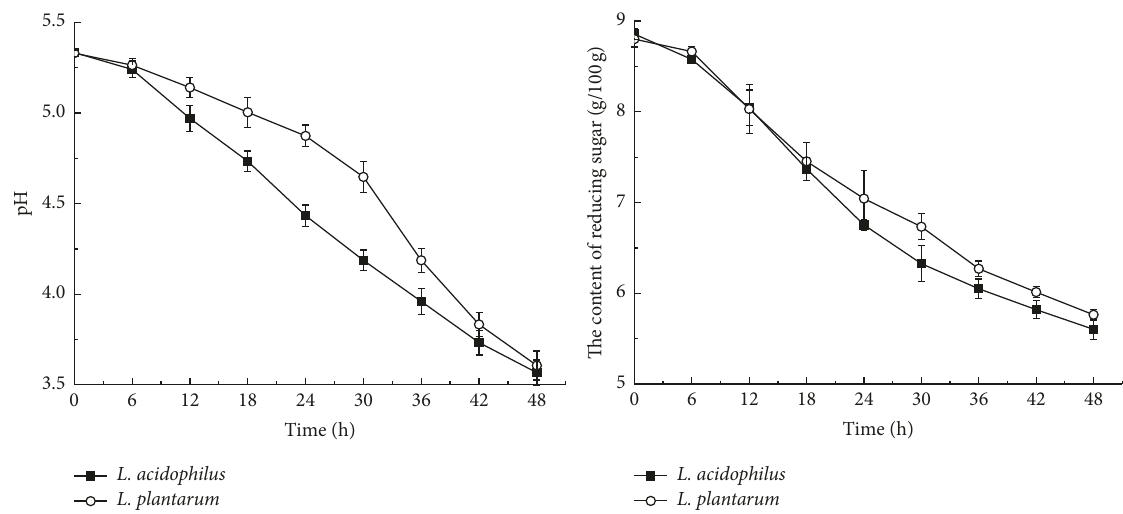
Figure 1: Changes in pH and reducing sugar content of the fermented papaya juices.